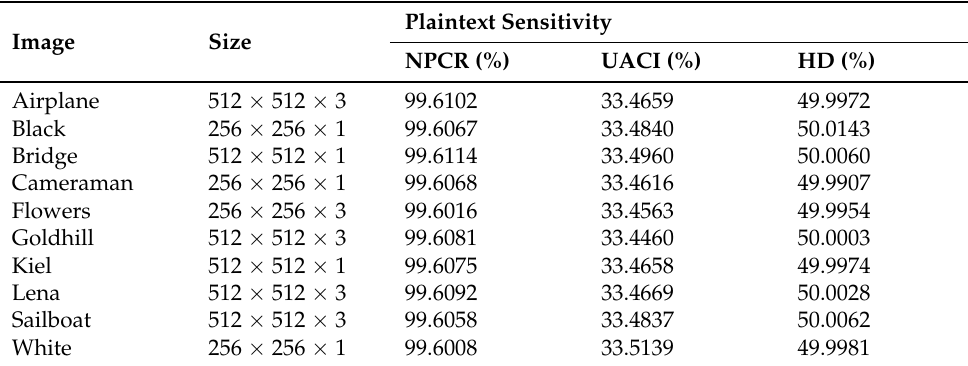
Table 11. NPCR, UACI, and HD of the plaintext sensitivity